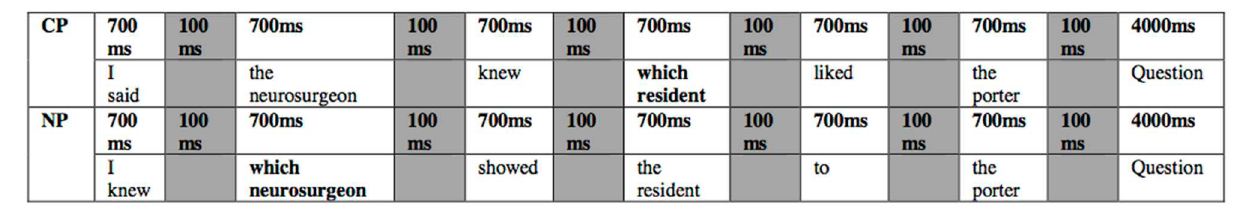
AC-PC, with full coverage of the frontal, temporal, and occipital lobes and partial coverage of the parietal lobes were acquired ( TR = 1 . 6 s, TE = 30 ms, Flip angle = 90 ◦ , FOV = 25.6 × 25.6 cm 2 , 64 × 64 matrix). Superior aspects of the parietal lobe could not be included to maintain the desired functional and anatomical resolution. Voxels were 4 × 4 × 4 mm in